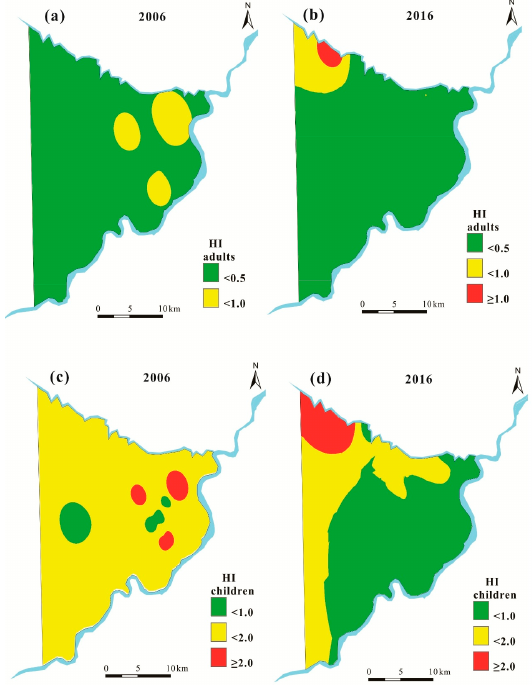
Figure 7. Spatial distribution of HI for adults ( a , b ) and children ( c , d ) in 2006 and 2016.